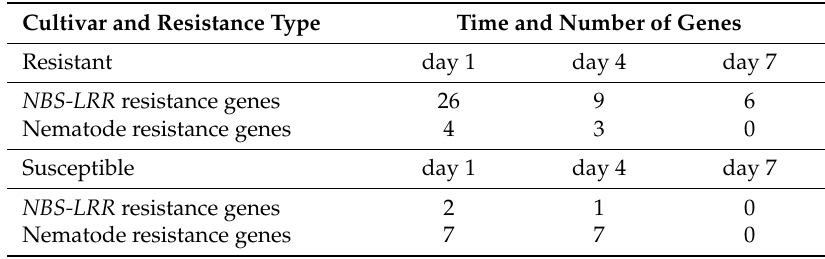
Table 2. The regulation of potential resistance DEG across time points. Cultivar and Resistance Type Time and Number of